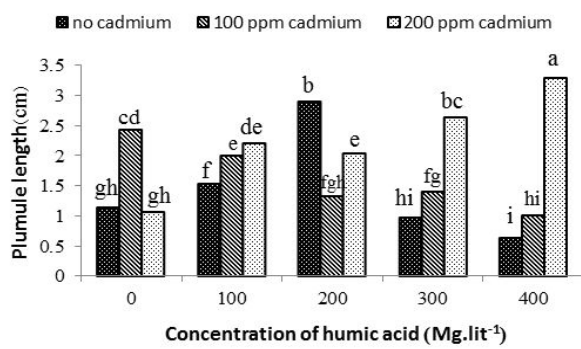
Fig. 1. Effect of Humic acid and cadmium concentration on pumpkin seedling radicle length